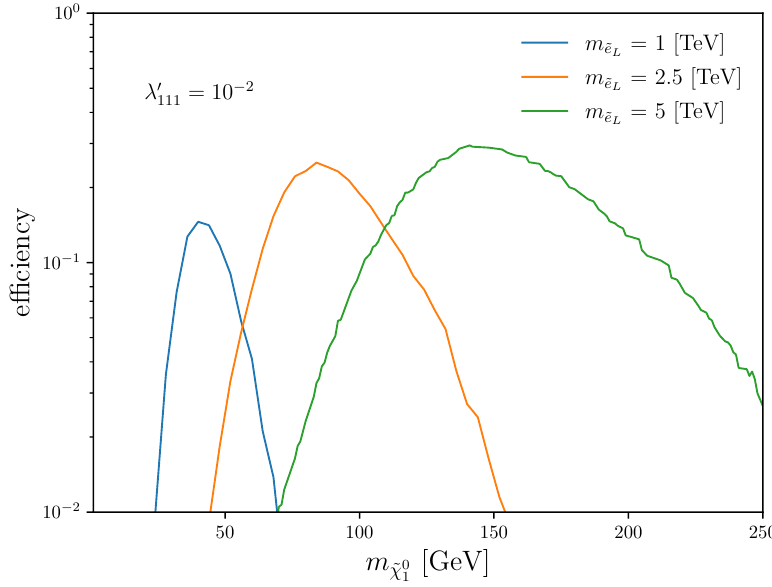
Figure 3 . DV selection efficiency as a function of the neutralino mass, for three values of the slepton mass. Here as a sample scenario, we fix λ 0